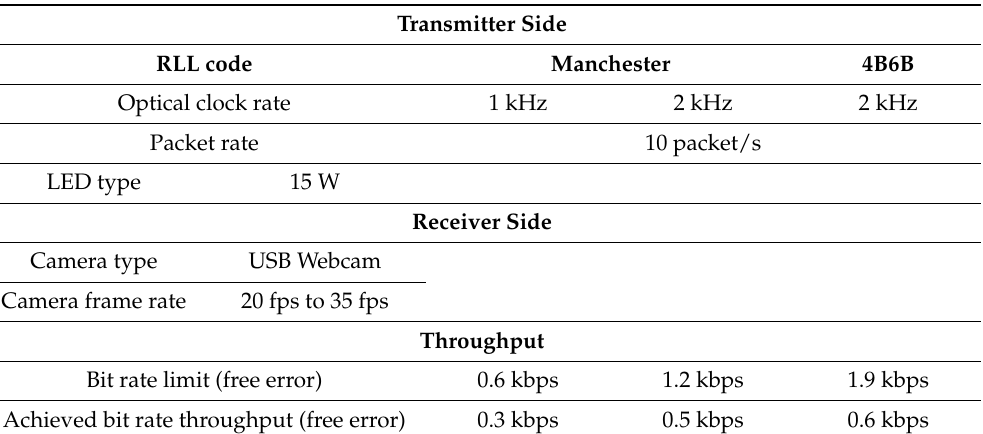
Table 8. Achieved System